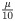
Assembly accuracy and contiguity for different insert size.The paternal and maternal genomes differes in 1% SNPs. The genome size is 5Mbp. The read length is 75bp and the sequencing coverage is 20X. The error rate of SNP/SV matrix is 1%. (a) The accuracy for different insert sizes μ with μ10 standard deviation; (b) The comparison of N10/N50 for different insert sizes.